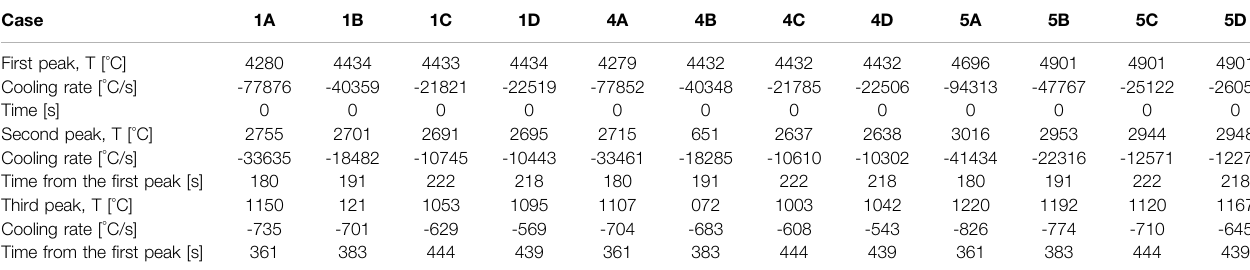
TABLE 6 | Summary of the thermal simulation results for all cases and